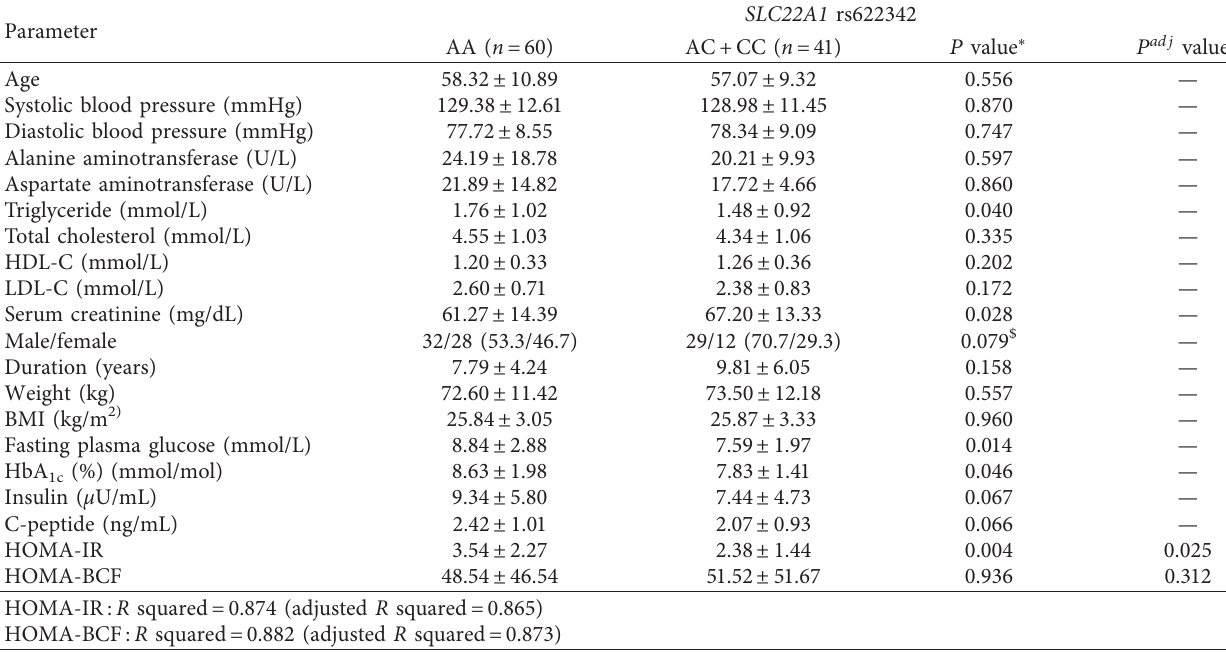
Table 1: Clinical characteristics of the subjects according to the genotypes of SLC22A1